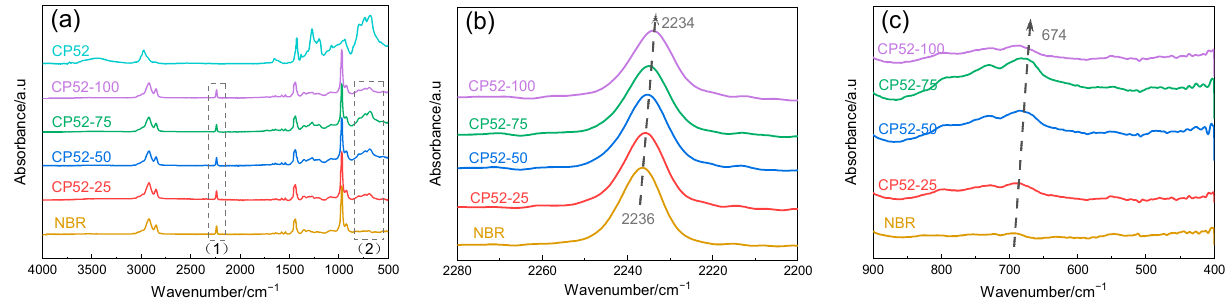
The position and intensity of the absorption peaks on the FTIR spectra can reflect the state of the functional groups inside the material and the intermolecular forces. Figure 3a is the FTIR spectra of NBR and CP52 and the CP52/NBR materials, wherein (1) and (2) are the characteristic absorption peaks of -CN and -Cl. It can be found that, with increased CP52 content, the peaks are red-shifted [11], and the stretching vibration peak of -CN gradually changes from 2236 cm − 1 to 2234 cm − 1 . The characteristic absorption peak of -Cl also moves to a lower frequency and continues to increase. The reason is that the strong induction effect leads to the averaging electron cloud distribution of the polar groups, causing the chemical bond between the polar groups and the main molecular chain to Figure 2. Effect of CP52 content on the damping performance of NBR. elongate, decreasing the wave number of the characteristic peak [12,13]. Figure 2. Effect of CP52 content on the damping performance of NBR.